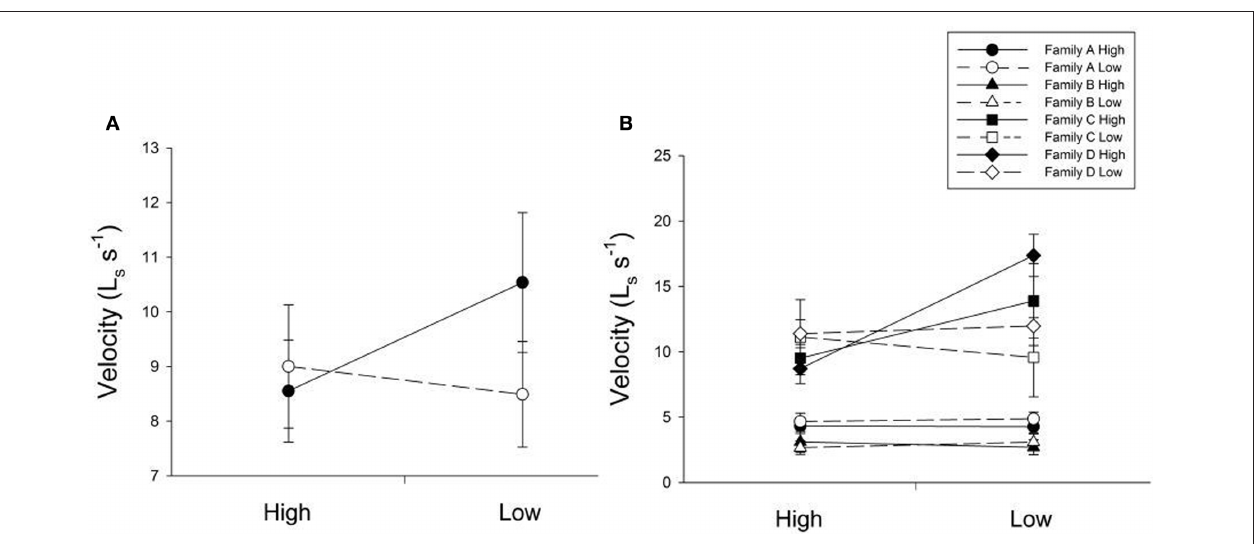
diet ration on swimming velocity in four full-sib families (A, B, C, and D; n = 93). Open lines and symbols represent low food rations days 0–30 and solid lines and symbols represent high food rations for days 0–30. The x-axis represents food ration for days 30–60. Error bars represent standard errors. Significant sources of variation included family ( P < 0 . 001), the interaction between family and diet for days 30–60 (Family × Diet 30 – 60 ; P = 0 . 0315), and the interaction between family and both dietary periods (Family × Diet 0 – 30 × Diet 30 – 60 ; P = 0 .